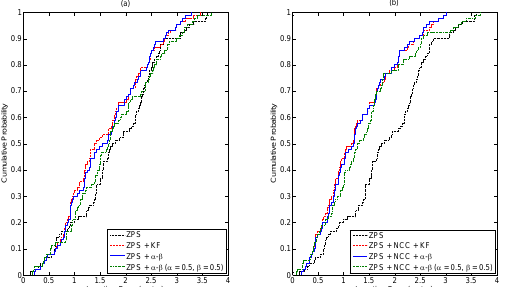
Figure 6. Comparison among (a) the ZPS (observed), the KF- based, and the α-β- based tracking approaches in terms of the CDF of the error distances; (b) the ZPS (observed), the KF- based, and the α-β- based tracking with the vision-assisted approaches in terms of the CDF of the error distances.